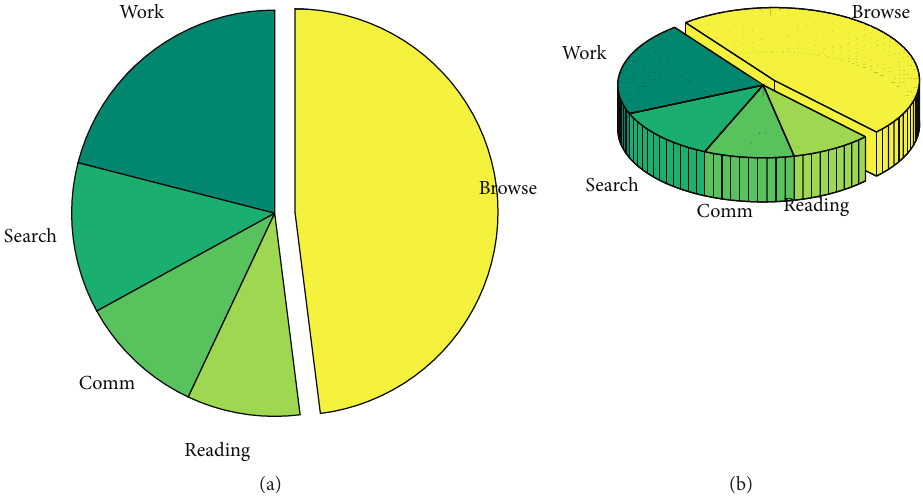
Figure 10: Pie chart (view events responding to mouse